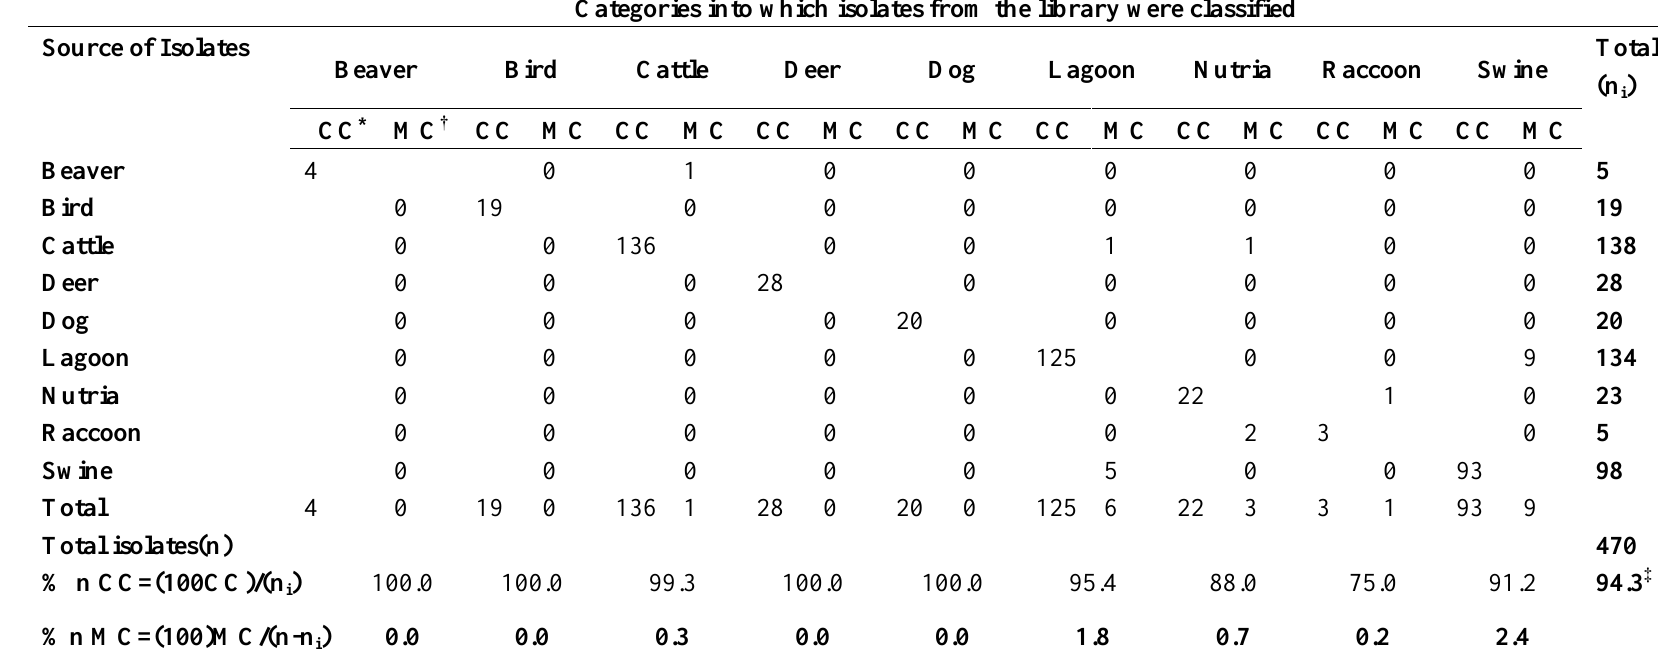
Table 3. Discriminant analysis of unique antibiotic resistance patterns (ARPs) with the application of an 80% correct classification certainty criterion used to classify E. coli from nine known sources into source